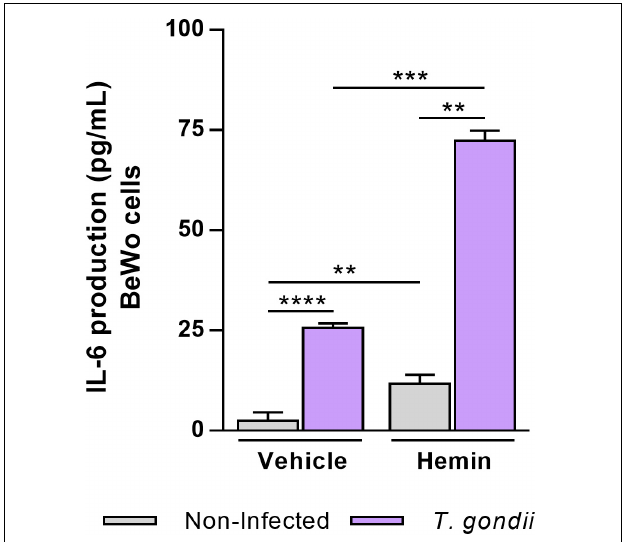
FIGURE 5 | Influence of HO-1 induction on IL-6 production by BeWo cells infected with T. gondii . Cell-free supernatants were collected from experiments carried out with BeWo cells infected by T. gondii and/or treated with hemin (80 µ M) and submitted to cytokine measurement by sandwich ELISA assay. Supernatants from non-infected and/or untreated cells were used as control. The levels of IL-6 secreted by BeWo cells were expressed as mean ± SEM from three independent experiments performed in six or eight replicates. The levels were measured in picograms per milliliter, and the detection limit for IL-6 was 4.7 pg/ml. Significant differences were statistically assessed by the Mann-Whitney test; ** P < 0.01; *** P < 0.001; **** P <